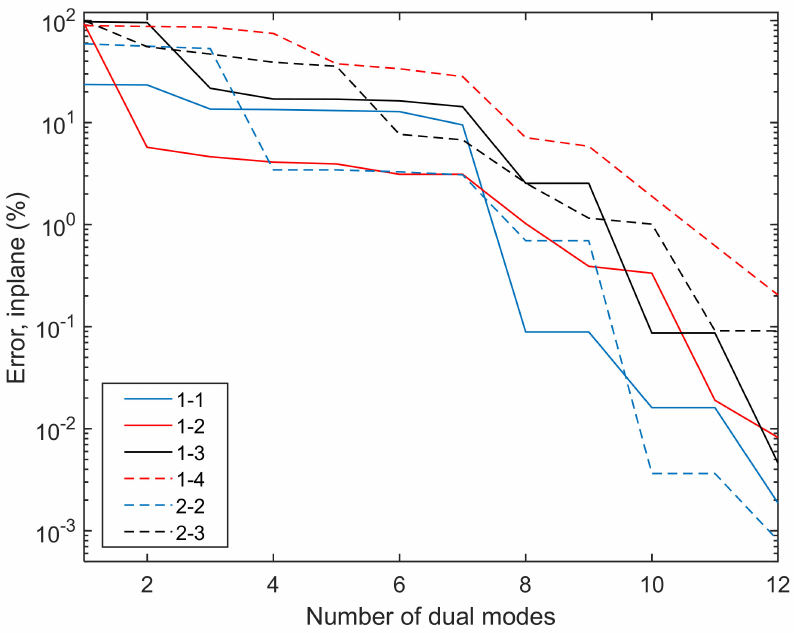
Figure 26. Representation errors of the combinations 1-1, 1-2, 1-3, 1-4, 2-2, and 2-3 as a function of the number of duals taken—1 dual per